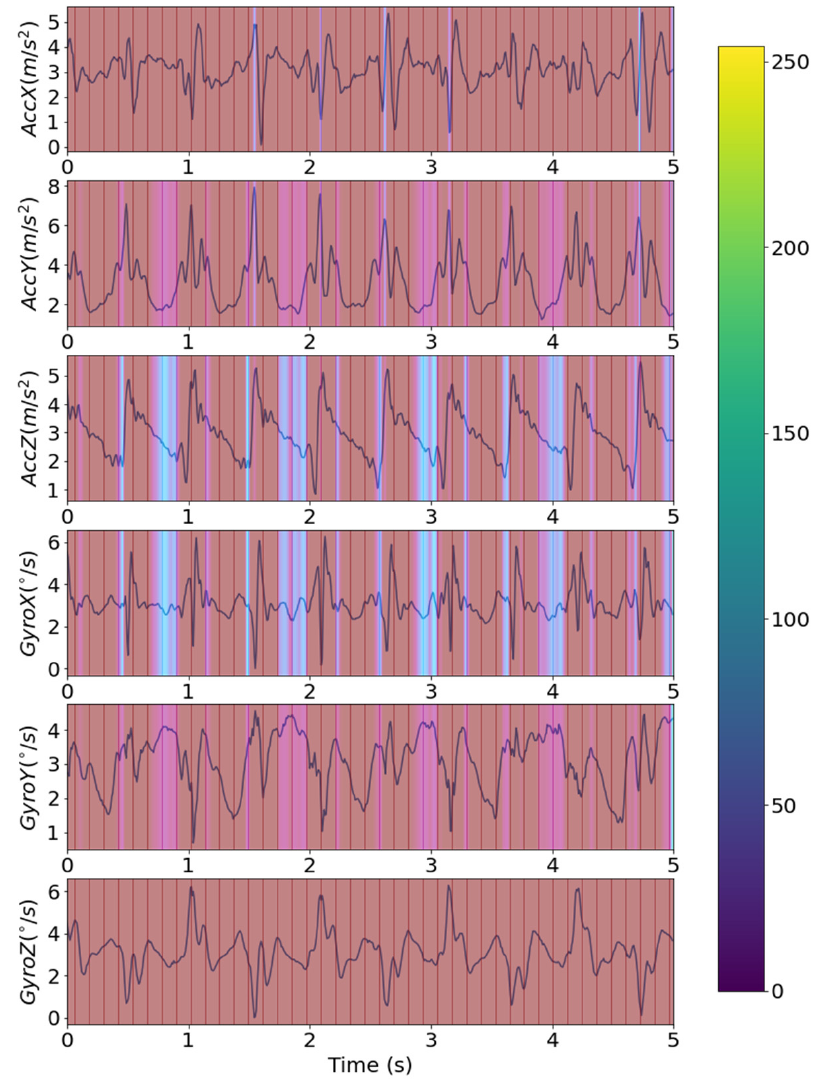
Figure 8. Example of heatmap using Grad-Cam.